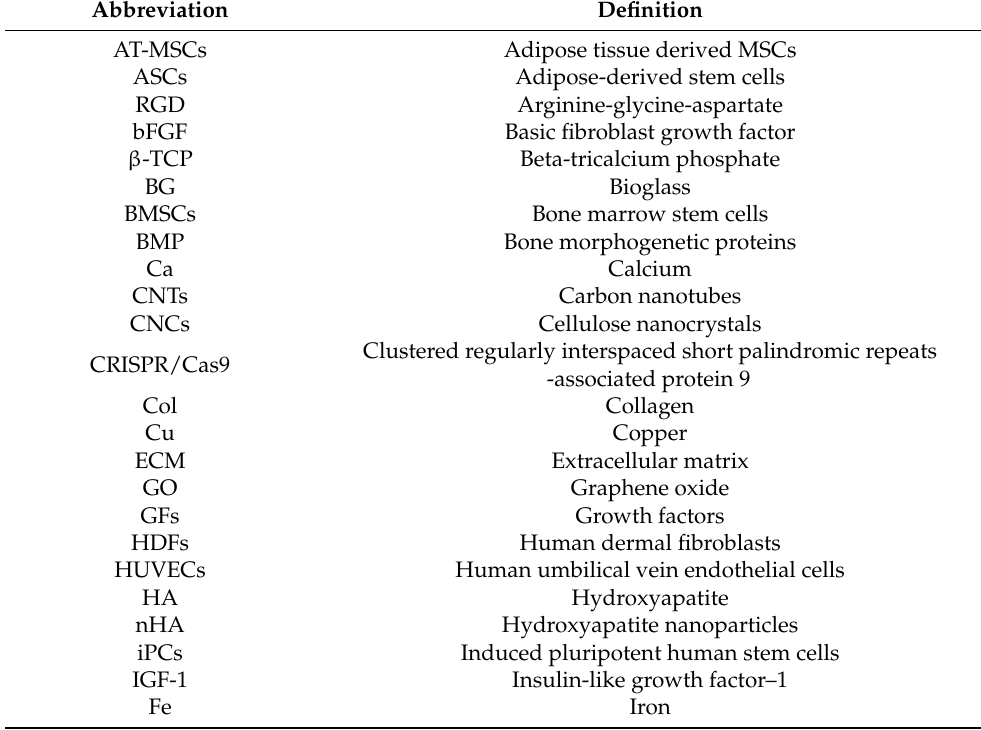
Table A1. Compilation of the abbreviations utilized in this